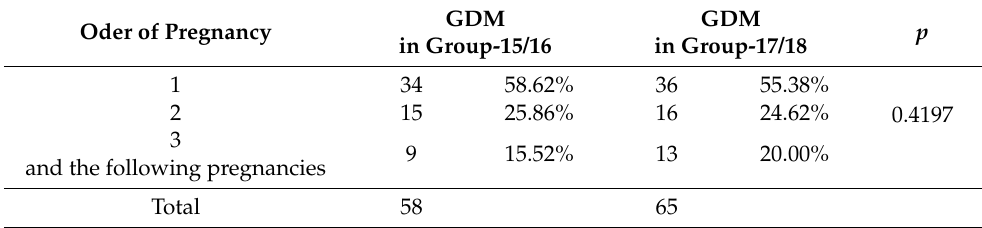
Table 2. Order of pregnancy in which Gestational diabetes mellitus (GDM) occurred.